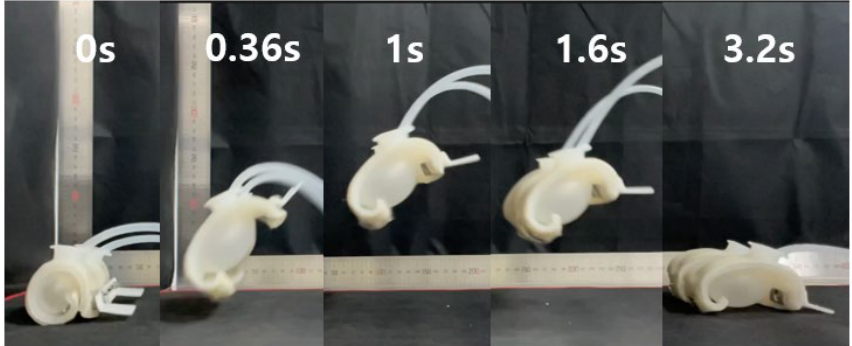
Figure 21. Drive motion of soft jumping robot.